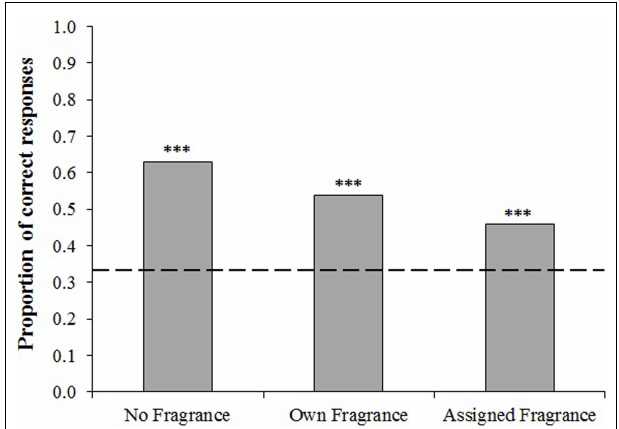
FIGURE 1 | Proportion of participants who correctly chose the odd one out on the triangle test. Dashed line indicates the proportion of correct responses which would be expected by chance (0.33). Binomial tests indicate significance above chance level *** p <